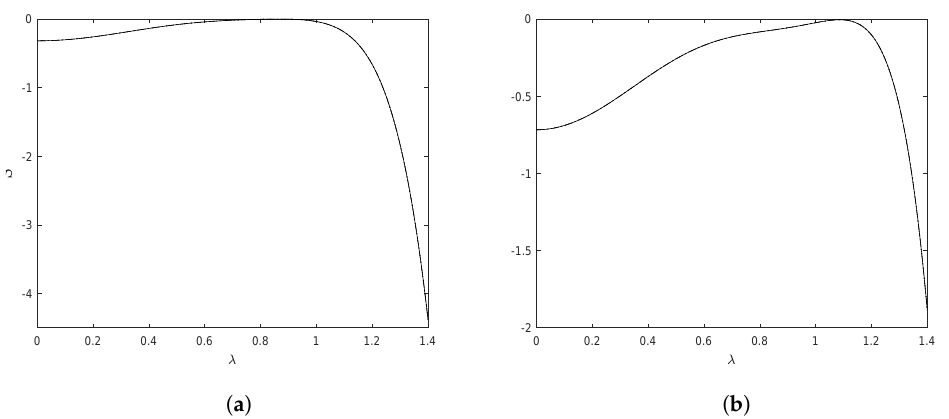
Figure 4. Evolution of the polynomial function S in Equation (16) as a function of λ with ( a ) δ = − β ; ( b ) δ = + β . The set of parameters used for simulation was µ = 0.05, ν = 0.03, β = 20%, f = ξ = 1, and h =